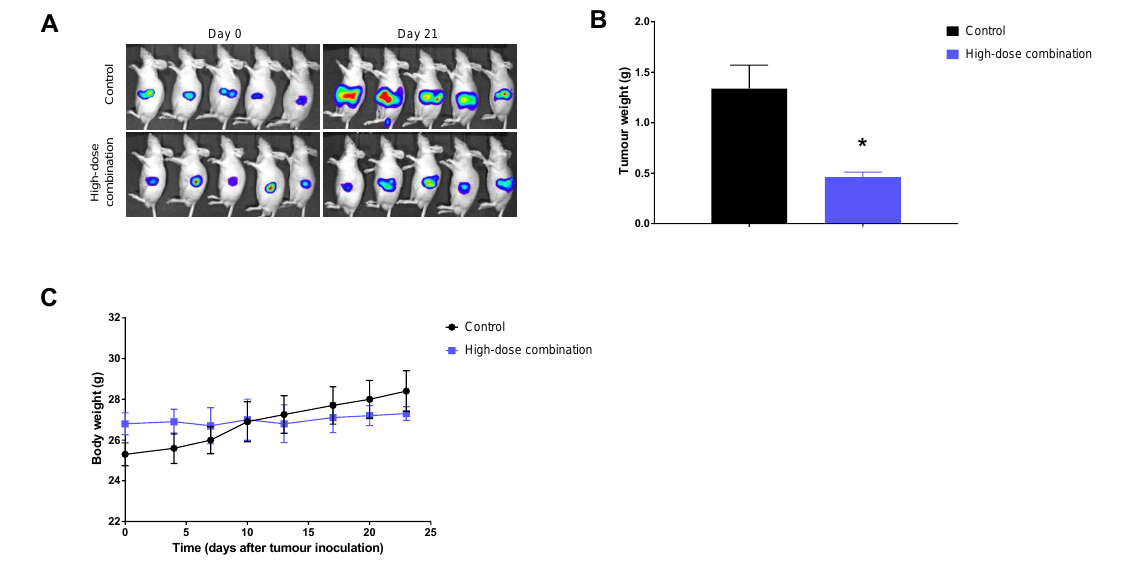
Figure 4. Efficacy and toxicity evaluation of the combination therapy in the BxPc-3-Luc orthotopic tumor model. ( A ) Bioluminescent images of mice from the control and high-dose combination therapy group obtained at the start and end of treatment (day 0 and day 21, respectively); ( B ) Tumor weights at the end of treatment and ( C ) Weight of mice over the course of therapy. The combination therapy significantly reduced tumor growth compared with the control group ( p = 0.006, Student’s t -test). No significant changes in weight were encountered by the treated mice compared with the controls. Data presented as mean ± SE; * indicates significantly different from controls.